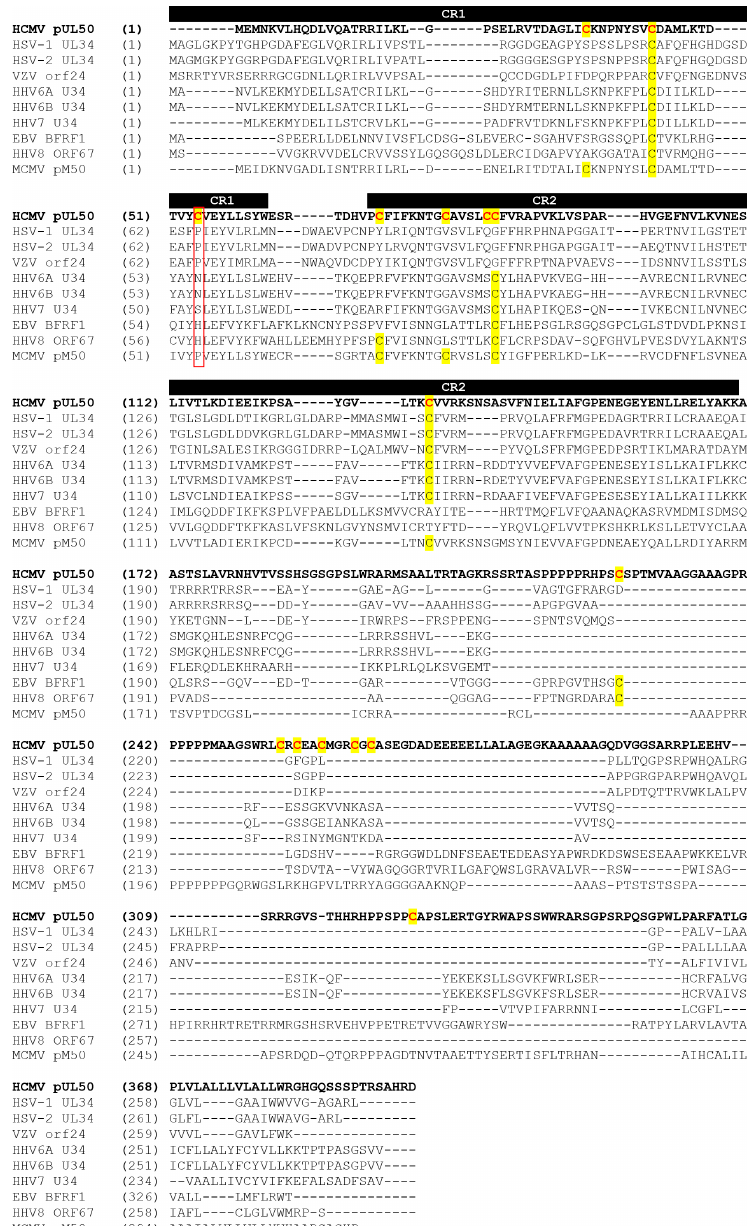
Figure 2. Protein sequence alignment of HCMV pUL50 and its homologs. The multiple sequence alignment was generated using Clustal Omega [65] (https://www.ebi.ac.uk/Tools/msa/clustalo/; accessed on 13 March 2023) and shows the full amino acid sequences of human cytomegalovirus (HCMV) pUL50 (UniProtKB entry: P16791), homologs of human herpesviruses (herpes simplex virus types 1 and 2 (HSV-1 UL34: P10218 and HSV-2 UL34: P89457)), varicella-zoster virus (VZV orf24: P09280), human herpesvirus 6 variants A and B (HHV-6A U34: P52465 and HHV-6B U34: Q9QJ35), human herpesvirus 7 (HHV-7 U34: P52466), Epstein–Barr virus (EBV BFRF1: P03185), human herpesvirus 8 (HHV-8/KSHV ORF67: Q76RF3) and the homolog of the murine cytomegalovirus (MCMV pM50: H2A365). Alignment coloring scheme: red on yellow, cysteine residues in the HCMV pUL50 sequence (red frame marks the uniqueness of the structurally exposed Cys54 residue of HCMV pUL50 compared to homologs); black on yellow, evolutionarily conserved cysteine residues in homologs of HCMV